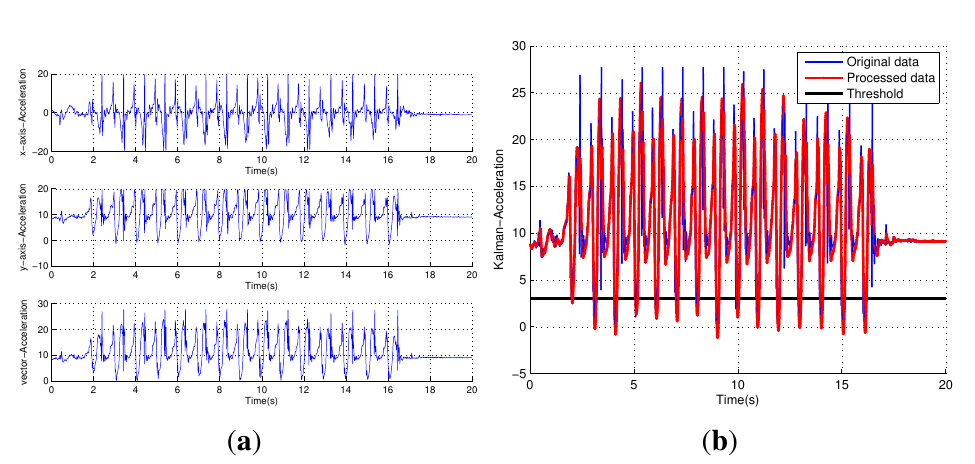
Figure 6. ( a ) The raw acceleration in the measurement; ( b ) the filtered acceleration data.